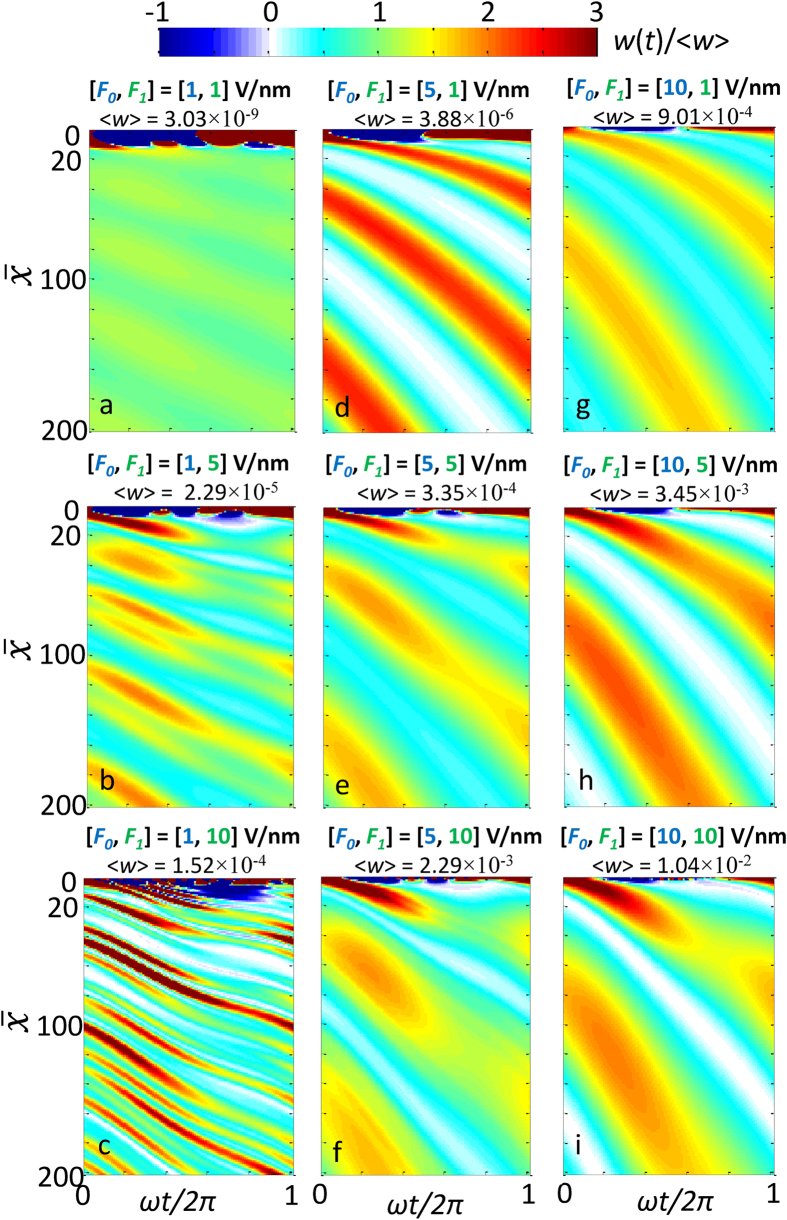
Time-dependent total emission current density w(x, t) normalized to the time-average emission current density , as a function of time and space, under various combination of dc electric field F0 and laser field F1, calculated from eq. (8).For the laser electric field F1 = 1, 5 and 10 V/nm, the corresponding laser intensity I = ε0cF12/2 is 1.33 × 1011, 3.33 × 1012 and 1.33 × 1013 W/cm2, respectively.